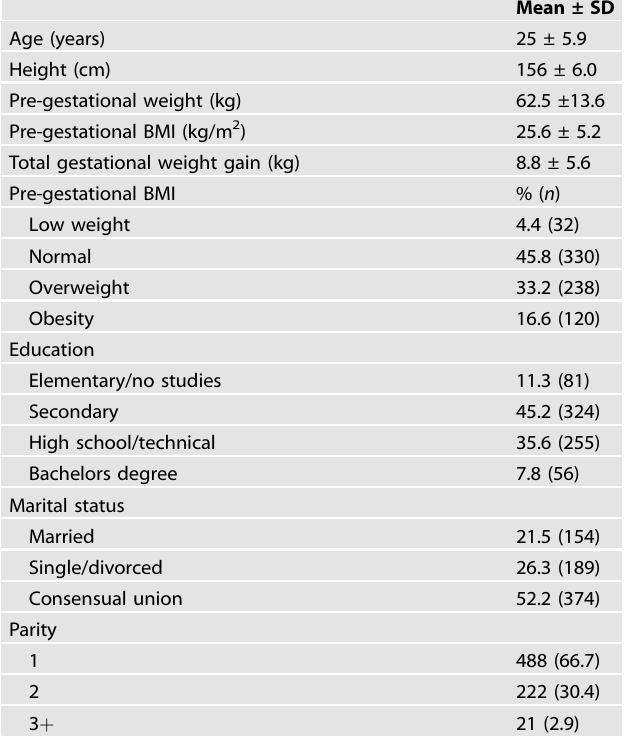
Table 1. Baseline characteristics of participants from the PRINCESA cohort, Mexico